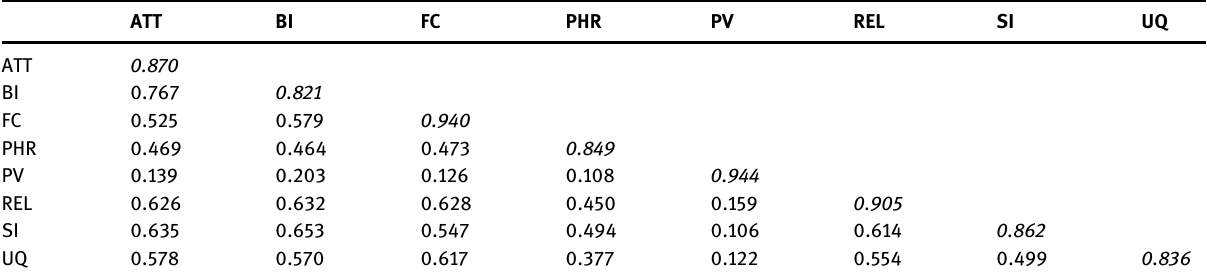
Table 3: Fornell – Larcker criterion